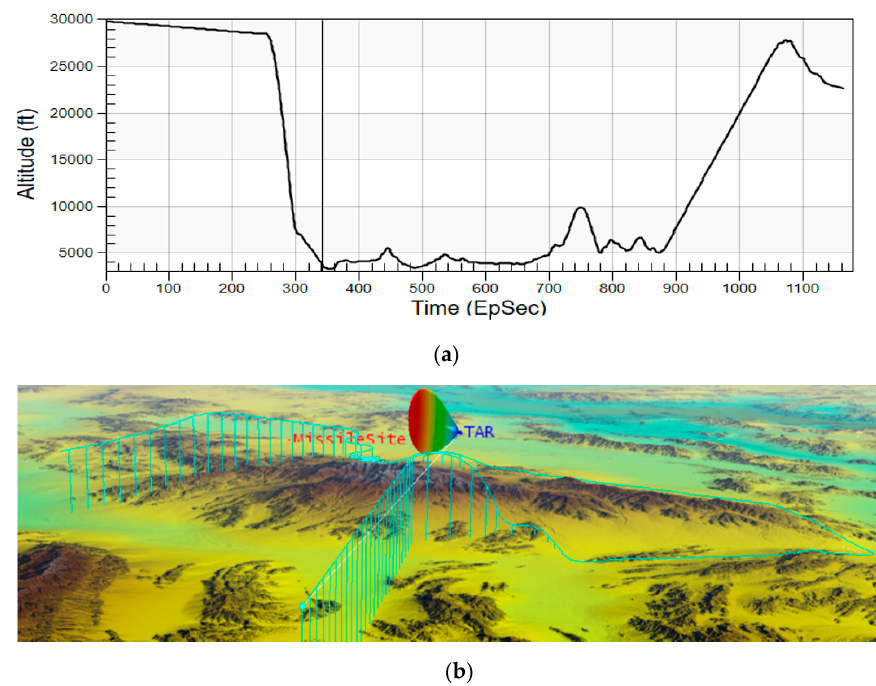
Figure 8. ( a ) Altitude of the aircraft in the scenario, ( b ) cyan drop-lines indicates the aircraft from terrain surface at different times (EpSec: Epoch Second).